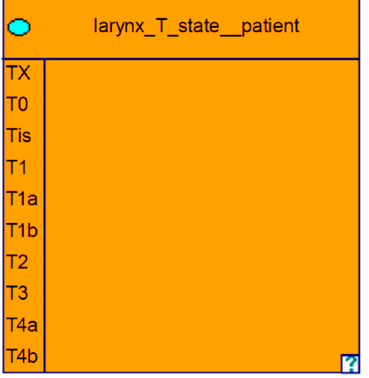
Figure 1. Node: T category with the different states.